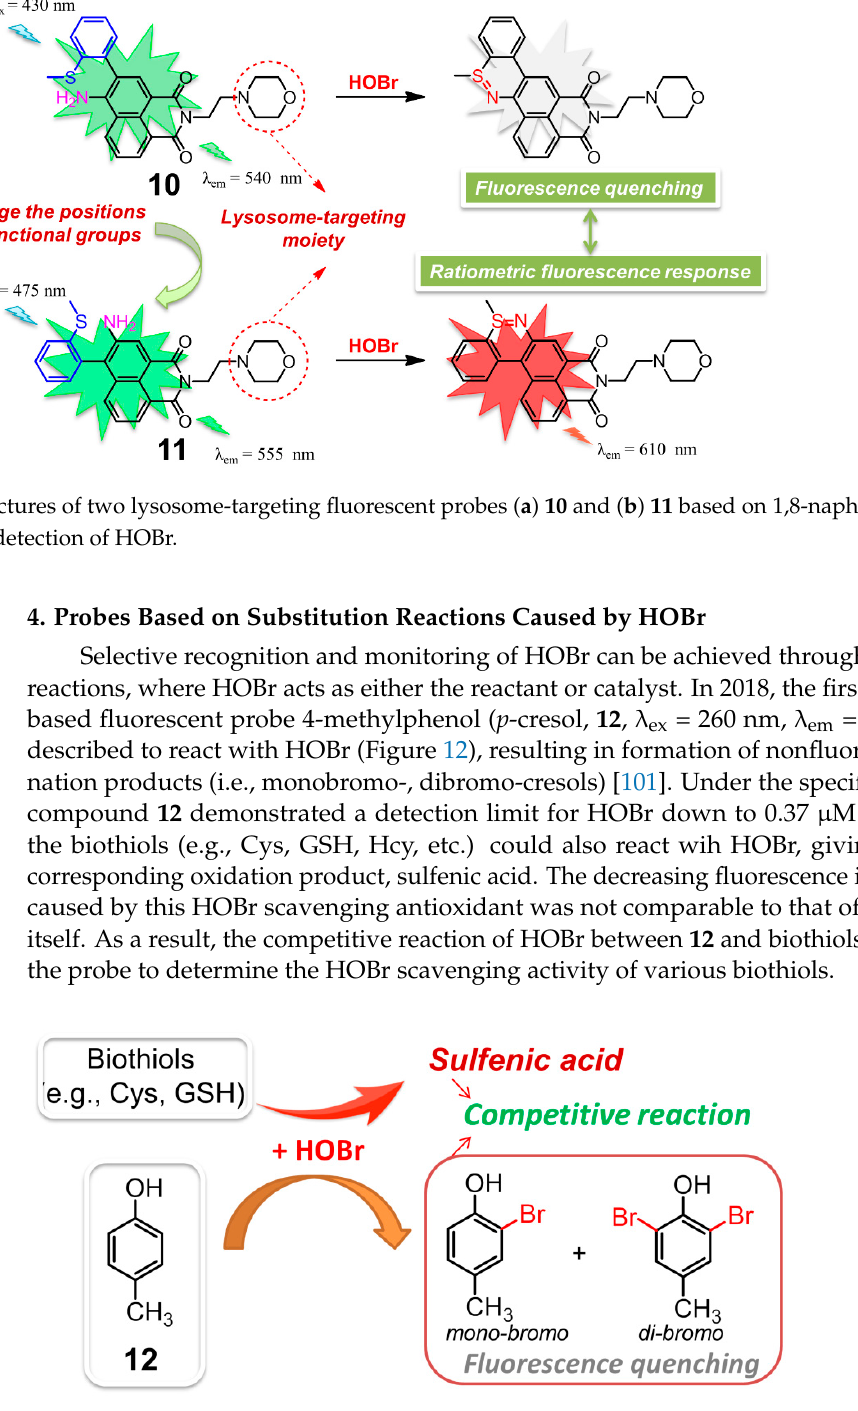
Figure 12. The competitive reaction of HOBr between 12 and biothiols.